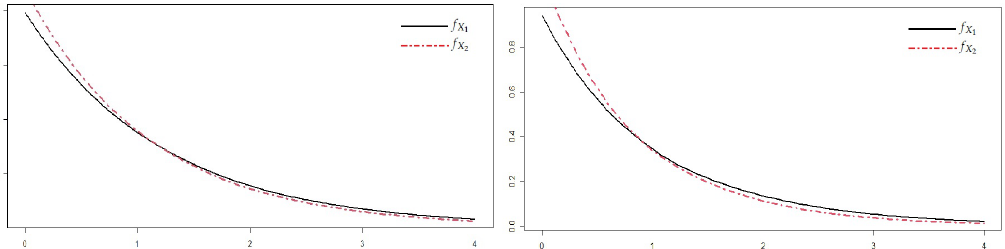
Figure 3. Marginal pdfs of composite Gumbel–Pareto distribution: left —with parameters from Figure 1; right —with parameters from Figure 2 ( f X